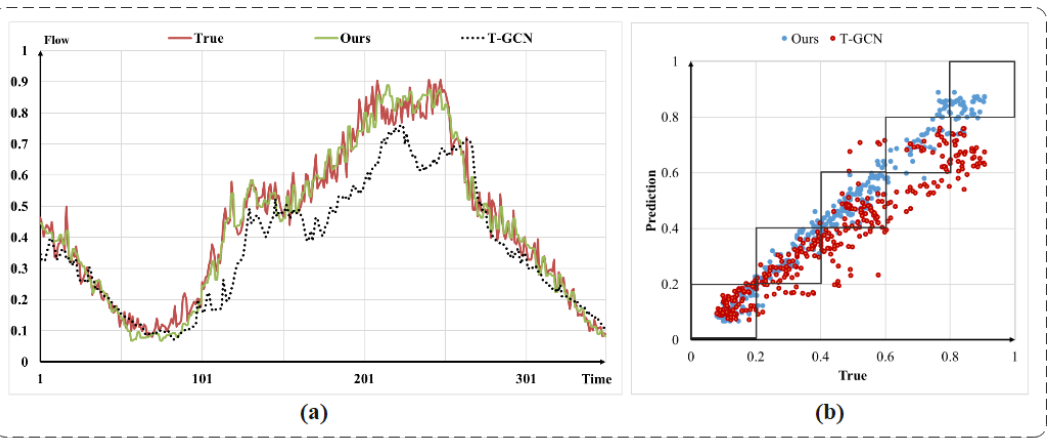
Figure 9. Comparison of DSGCN and T-GCN prediction effects. ( a ) is a time-series variation plot. ( b ) is a numerical scatter plot.